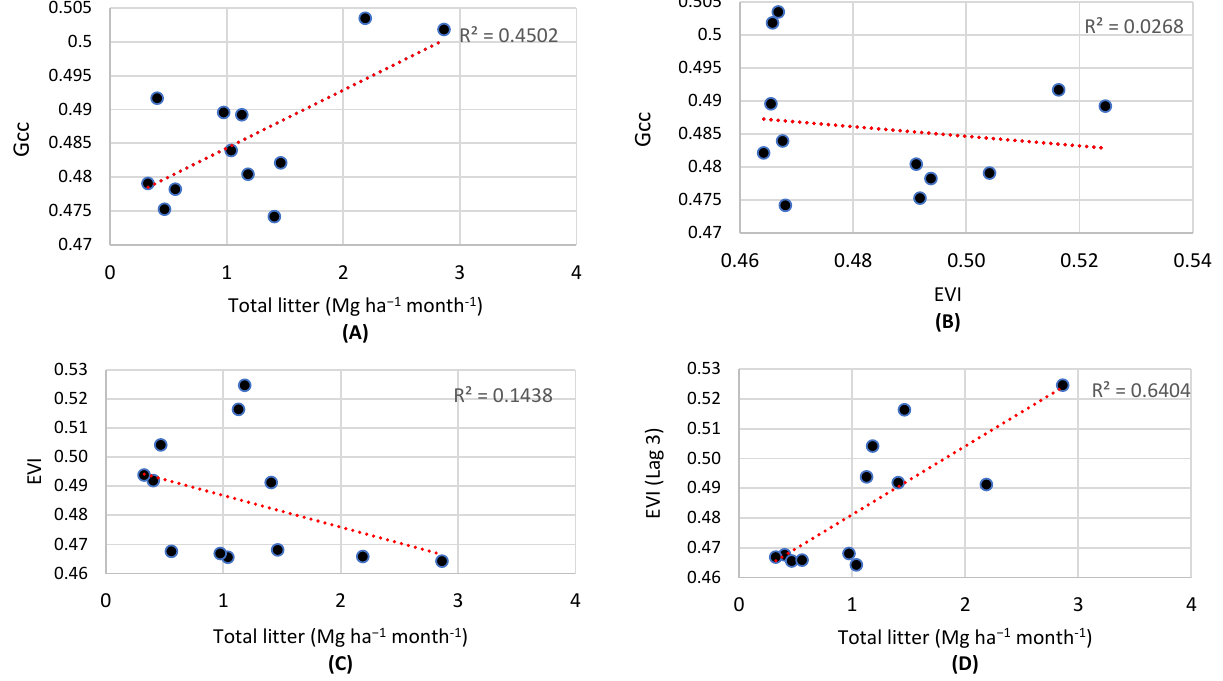
Figure 4. Relationship between EVI, Gcc indices and total litter, RJA site. ( A ) Gcc (2000–2017) × total litter (2016–2018), monthly long-term average; ( B ) Gcc × EVI (Sep. 2015–Dec. 2017); ( C ) Total litter (2016–2018) × EVI (2000–2017) monthly long-term average ( D ) Total litter (2016–2018) × EVI (2000–2017) monthly long-term average, with 3 months lag in EVI.